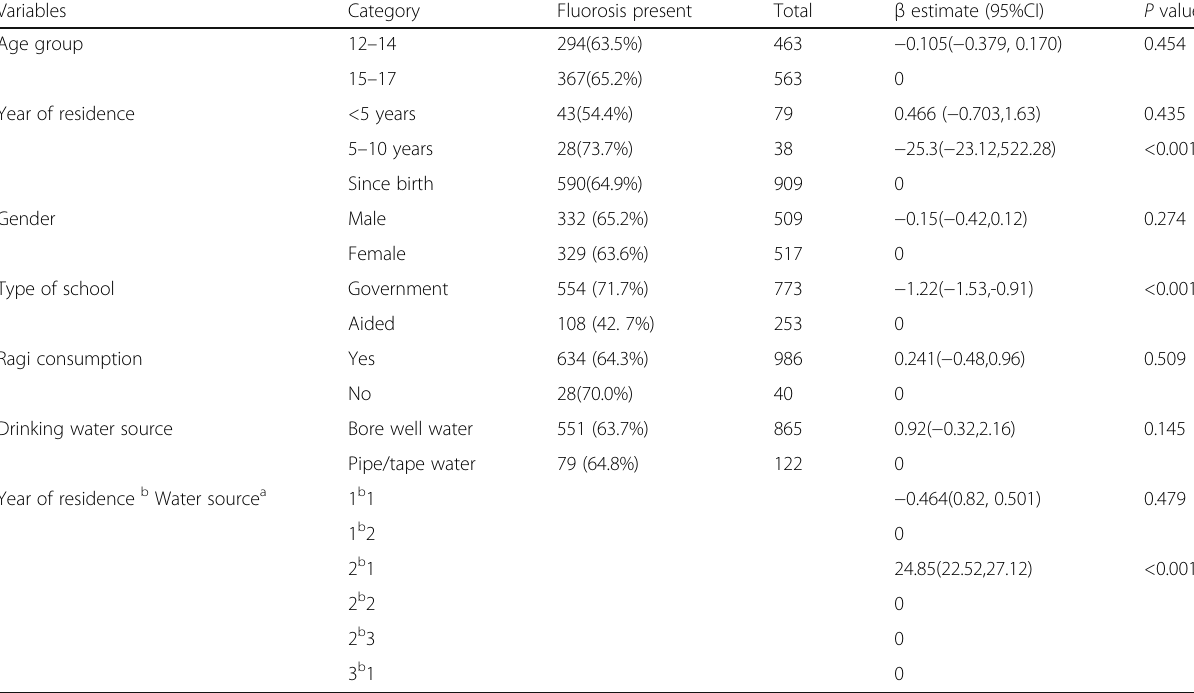
Table 3 Generalized estimated equation (GEE) multivariable model of factors associated with prevalence of dental fluorosis ( n = 1026)